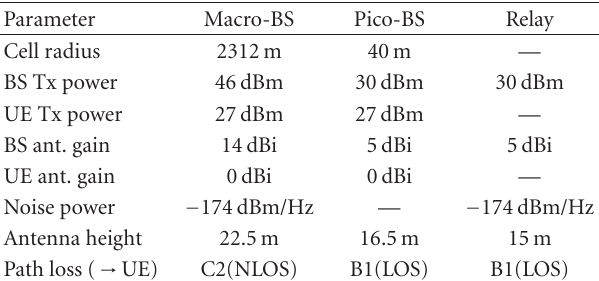
Table 3: Simulation